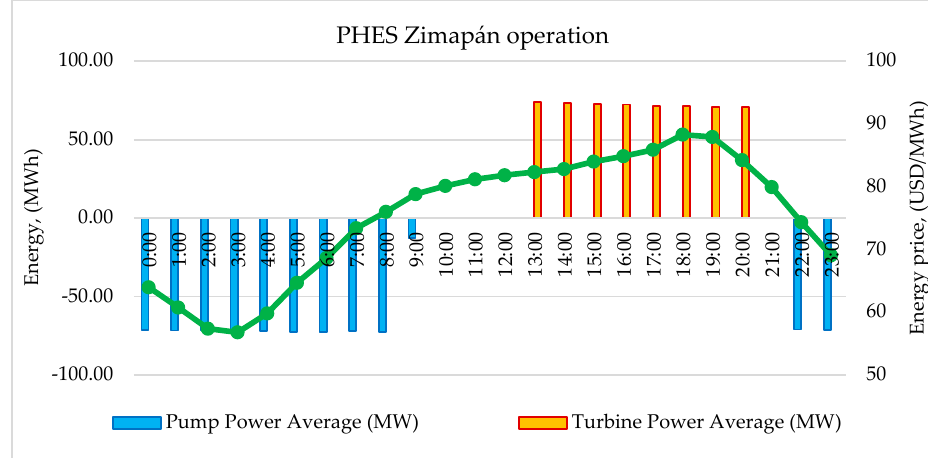
Figure 16 . Optimum operation of the booster station . Own source with analysis of results. Figure 16. Optimum operation of the booster station. Own source with analysis of